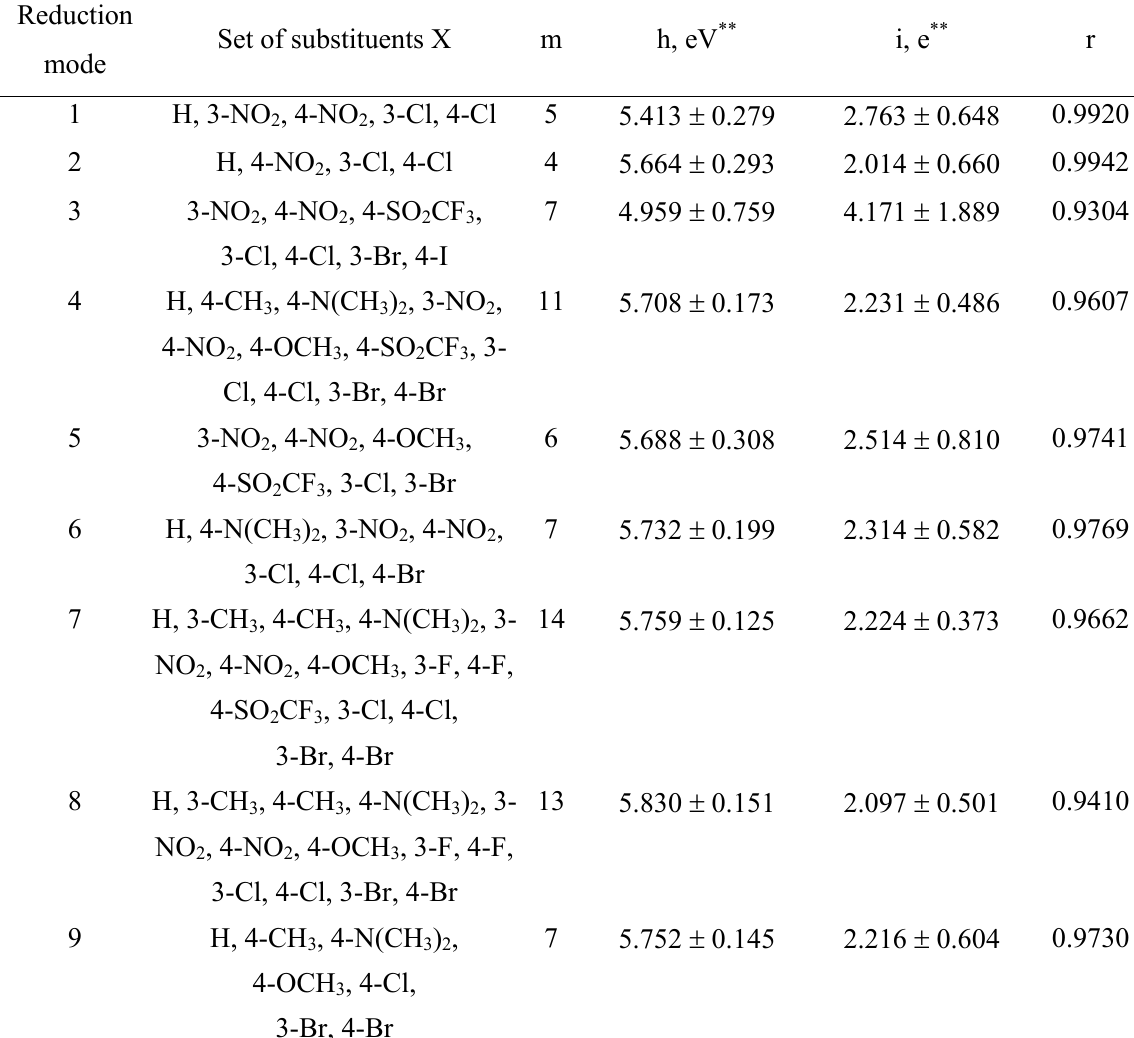
H N + ≡ N 6 4 Cl electrode) [5- 2 2